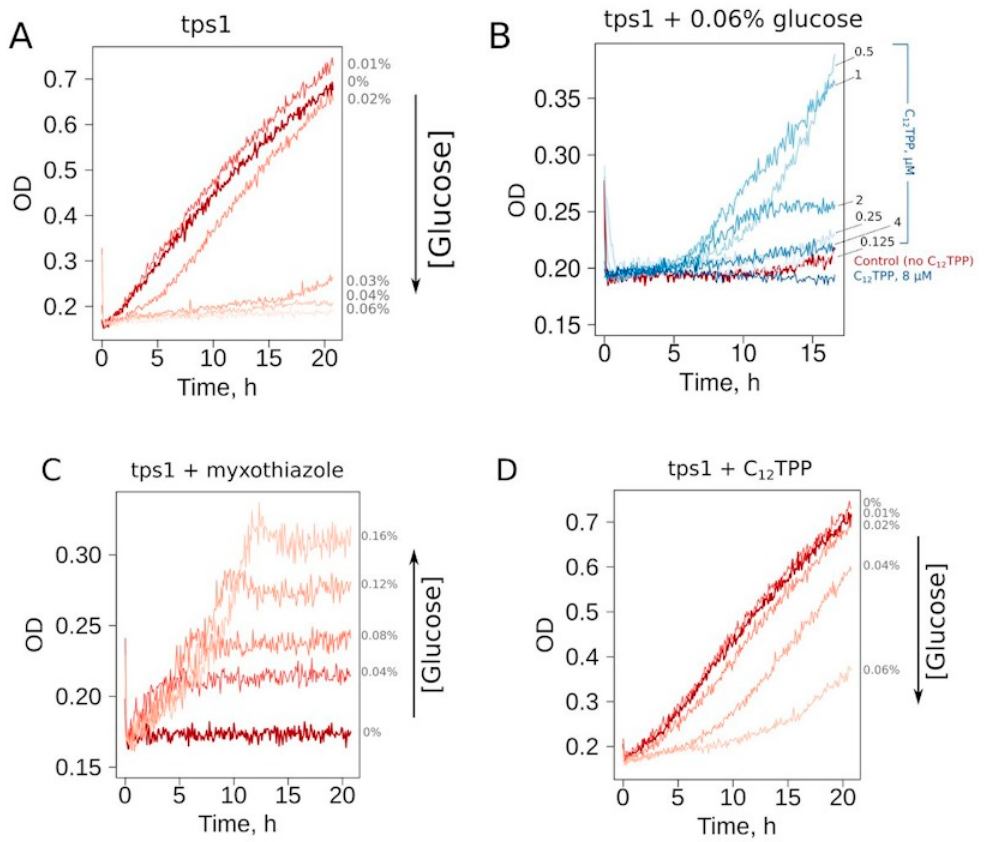
Figure 2. C 12 TPP and myxothiazol alleviate the glucose-induced inhibition of the growth of tps1-delta cells in a different fashion. The representative growth curves. ( A ) Titration of glucose. ( B ) Titration of C 12 TPP. ( C ) Titration of glucose in the presence of myxothiazol, 1 µ M. ( D ) Titration of glucose in the presence of C 12 TPP, 1 µ M.